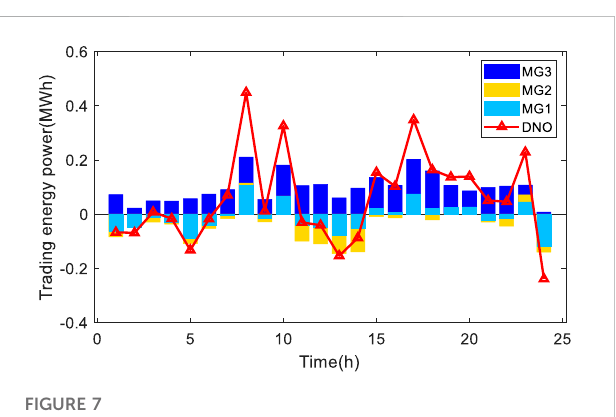
FIGURE 5 Control result of transferable load.